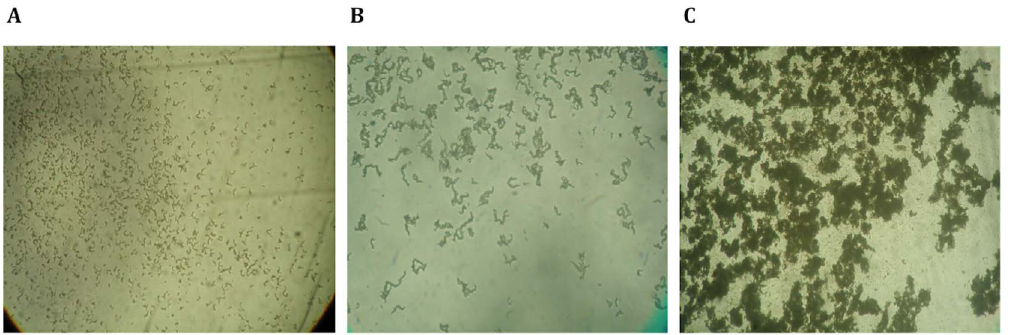
Figure 1. Temporal variation of the morphological characteristics of MTB cords in MODS culture observed at 100X total magnification. (A) Day 3 of culture; (B) Day 10 of culture; (C) Day 15 of culture. Cords observed at day 10 are highly specific for MTB.